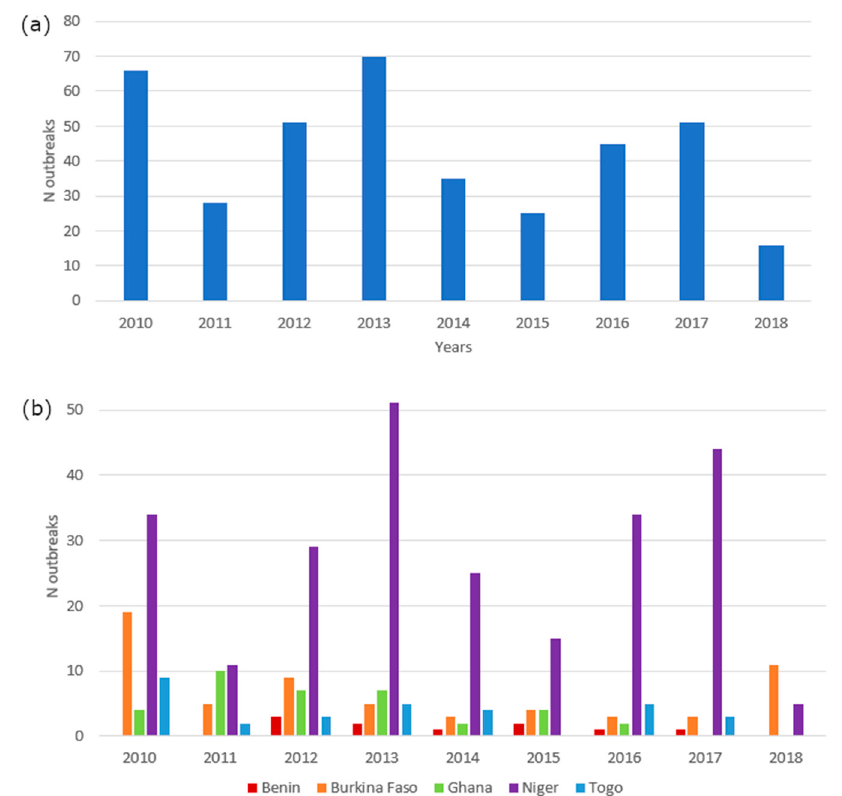
Figure 2. Number of anthrax outbreaks by year across the study area ( a ) and by country ( b ) between January 2010 and November 2018 (OIE-WHAIS data).